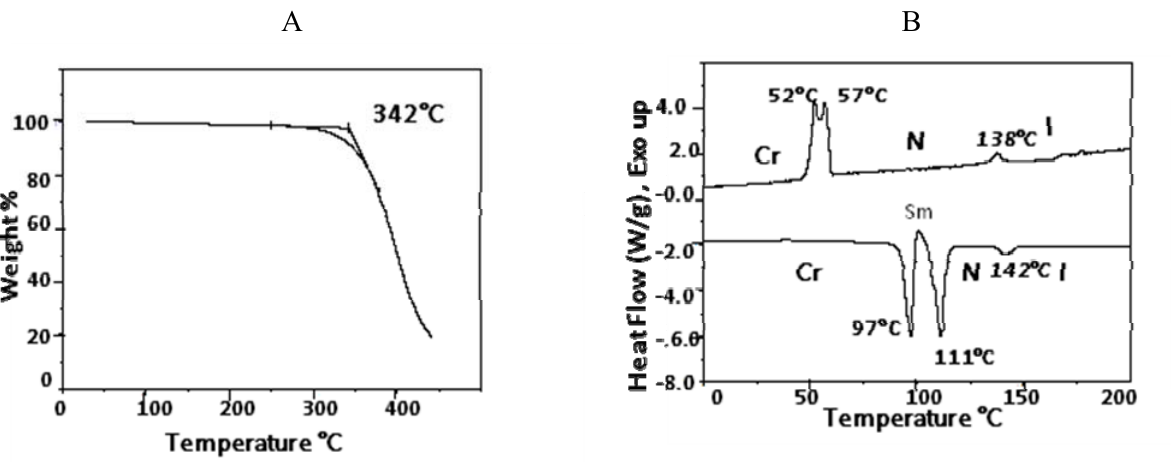
Figure 8. (8a) Thermogravemetric analysis of benzoic acid, 4-(4-pentenyloxy)-, 2-